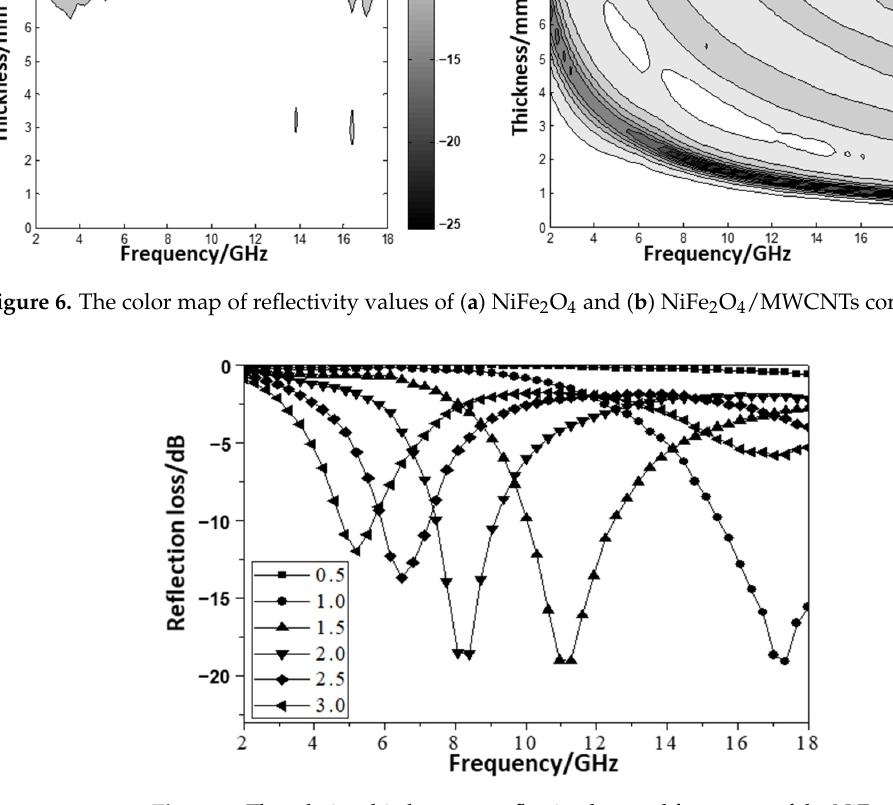
Figure 7. The relationship between reflection loss and frequency of the NiFe 2 O 4 /MWCNTs compo- site with different